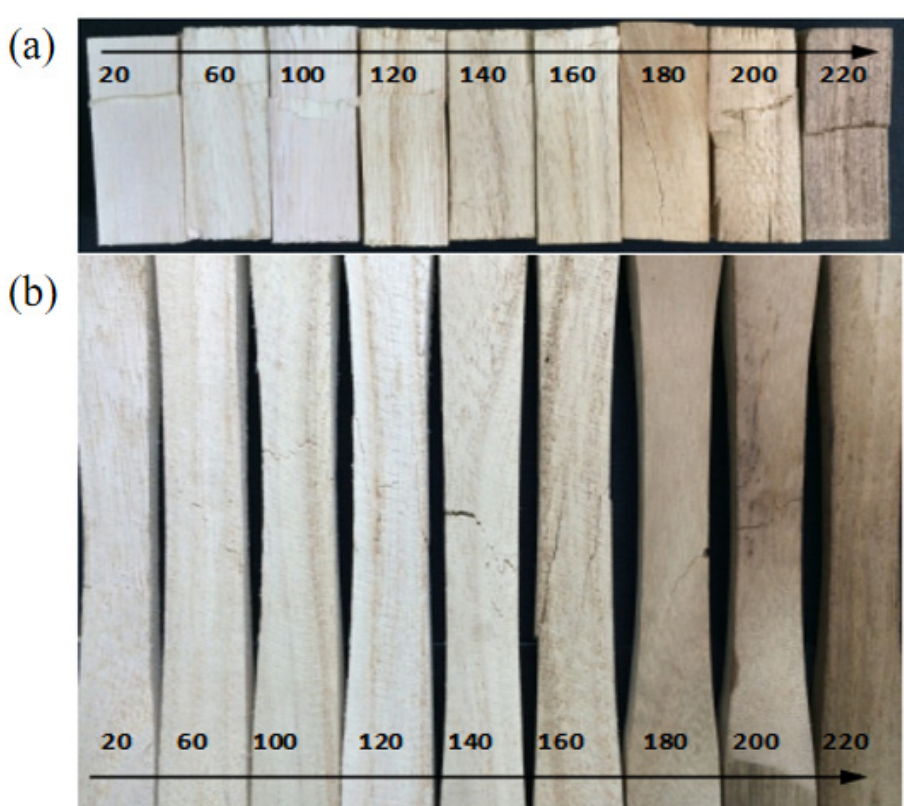
Figure 6. Average moisture content progressions at elevated temperatures.